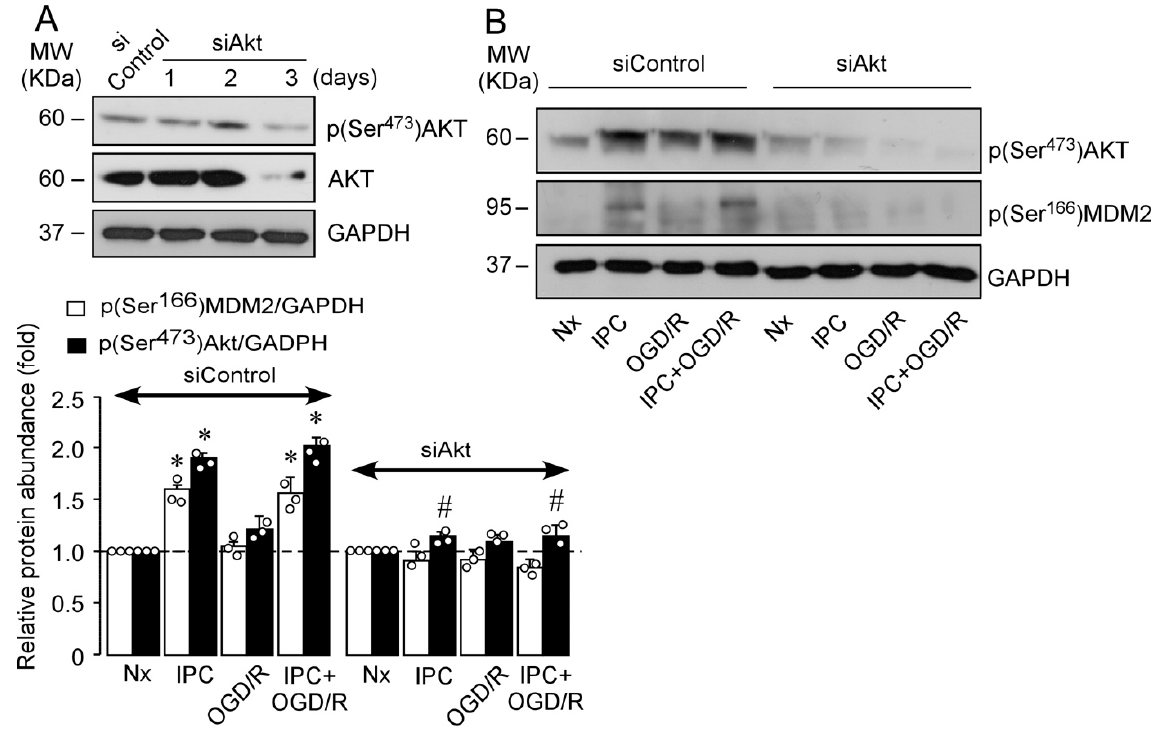
Figure 3. AKT downregulation prevents IPC-induced phosphorylation of AKT at Ser 473 and MDM2 at Ser 166 in neurons after ischemia. AKT knockdown was performed by siRNA (siAkt) transfection for ( A ) 1, 2, and 3 days in HEK-293T or ( B ) neurons at 6 DIV were transfected with siAkt for 3 days followed by Nx, IPC, OGD/R, and IPC + OGD/R protocols. p(Ser 473 )AKT, AKT, and p(Ser 166 )MDM2 protein levels were analyzed by Western Blot. GADPH was used as loading control. Representative blots are shown. Relative protein abundance quantification from three different neuronal cultures is shown. MW, molecular weight. Data are means ± SEM. Statistical analysis of the results was evaluated by one-way ANOVA followed by Bonferroni post hoc. * p < 0.05 versus siControl Nx and siControl OGD/R; # p < 0.05 versus siCon- trol IPC and IPC+OGD/R.